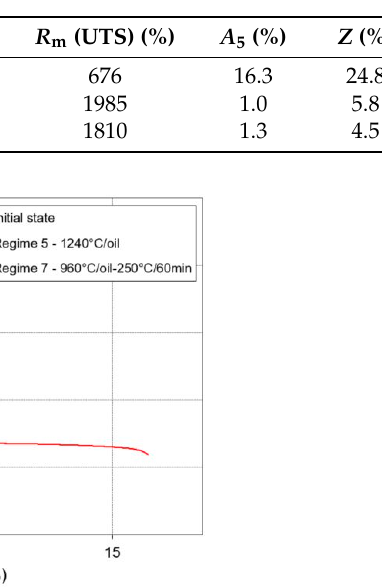
Figure 14. Stress-strain curves after micro-tensile test with significant difference between samples in initial state with ferritic matrix (red curve), after conventional heat treatment (green curve), and after semi-solid processing with forming (blue curve).